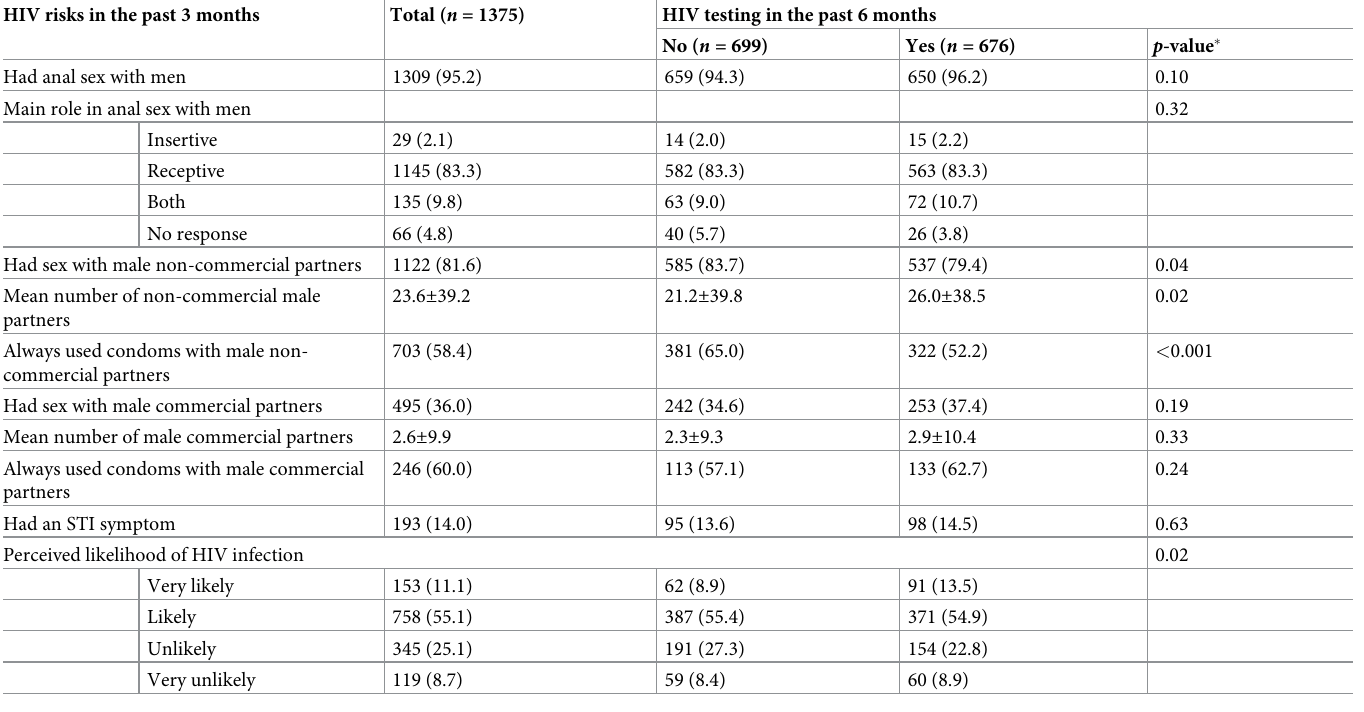
Table 2. Comparisons of sexual behaviors among transgender women who had and who had not tested for